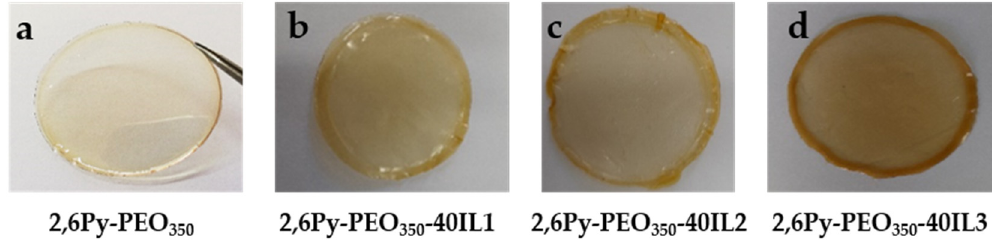
Figure 1. Pictures of the prepared neat polymer ( a ) and polymer-IL composite membranes with ( b ) 40 wt% of IL1, ( c ) 40 wt% of IL2 and ( d ) 40 wt% of IL3. ( b ) 40 wt% of IL1, ( c ) 40 wt% of IL2 and ( d ) 40 wt% of